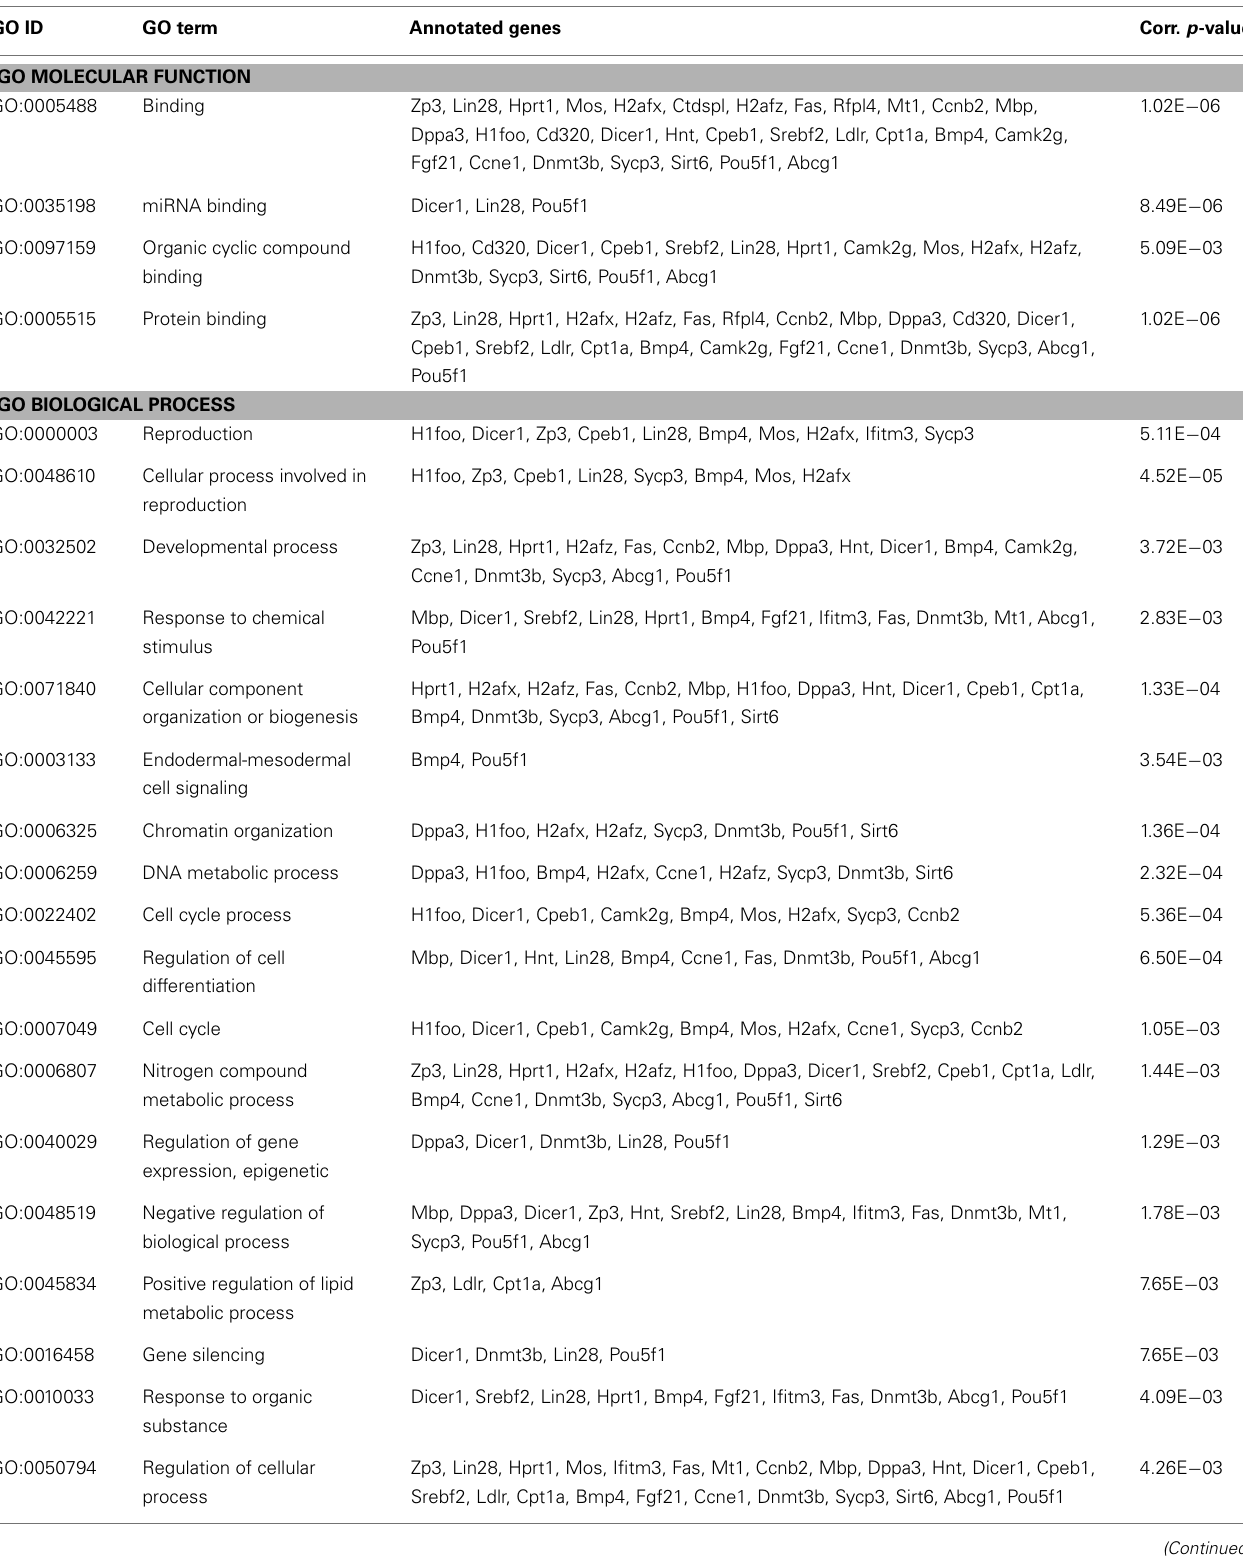
Table 3 | Gene ontology analysis of validated mmu-miR-33-5p target